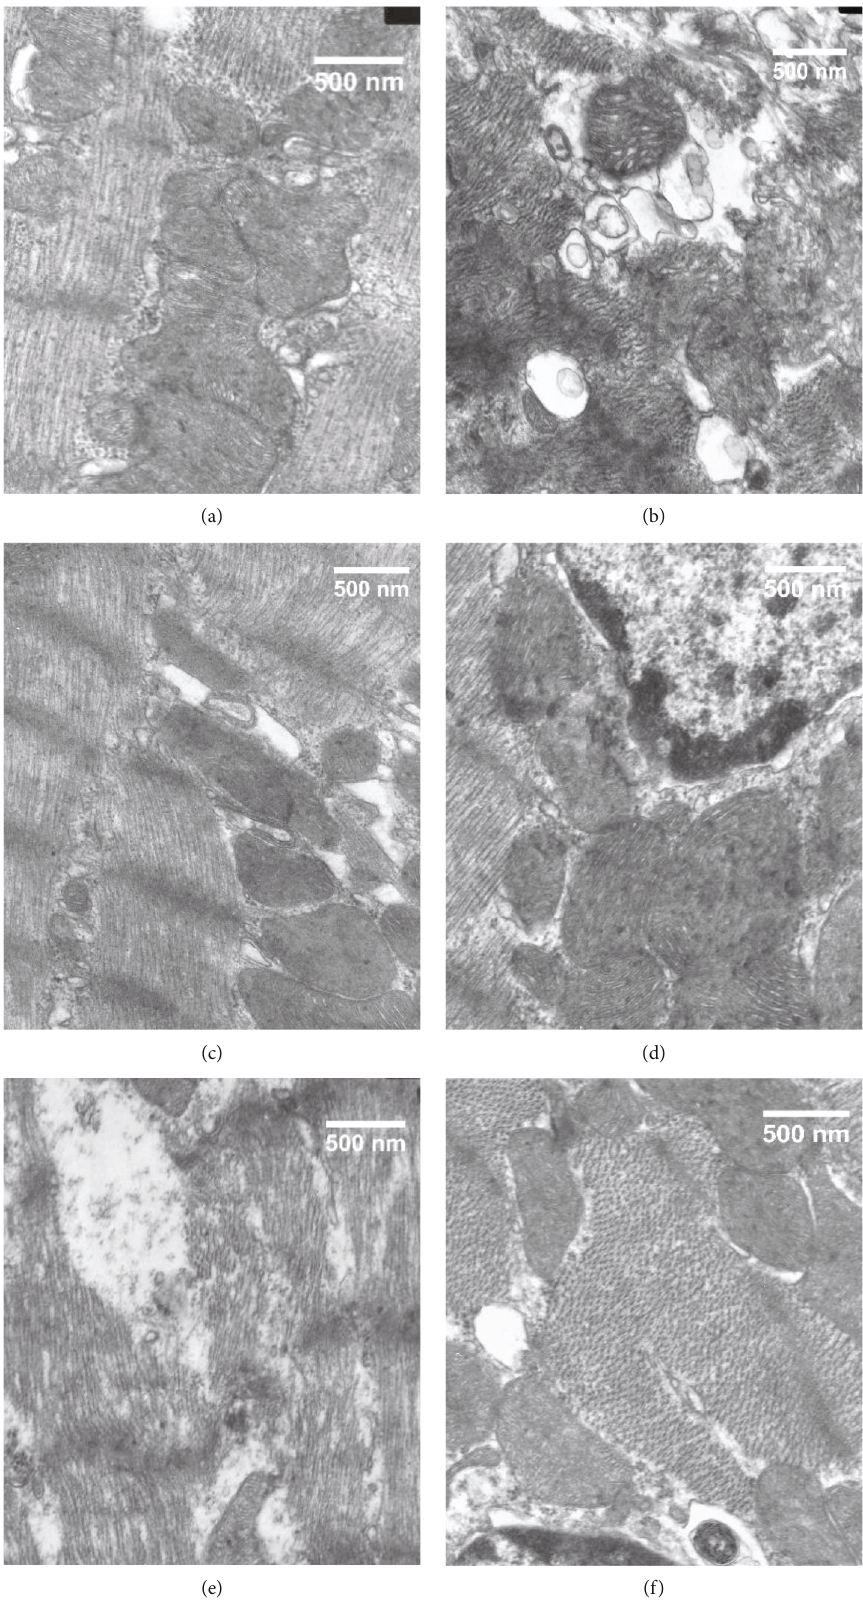
Figure 5: Ultrastructural changes in myocardial fi bers and mitochondria in the di ff erent groups ( × 15,000). Scale bar, 500nm. (a) Sham group; (b) I/R group; (c) RIC group; (d) I/R+Fas group; (e) RIC+Wort group; (f) RIC+Fas+Wort